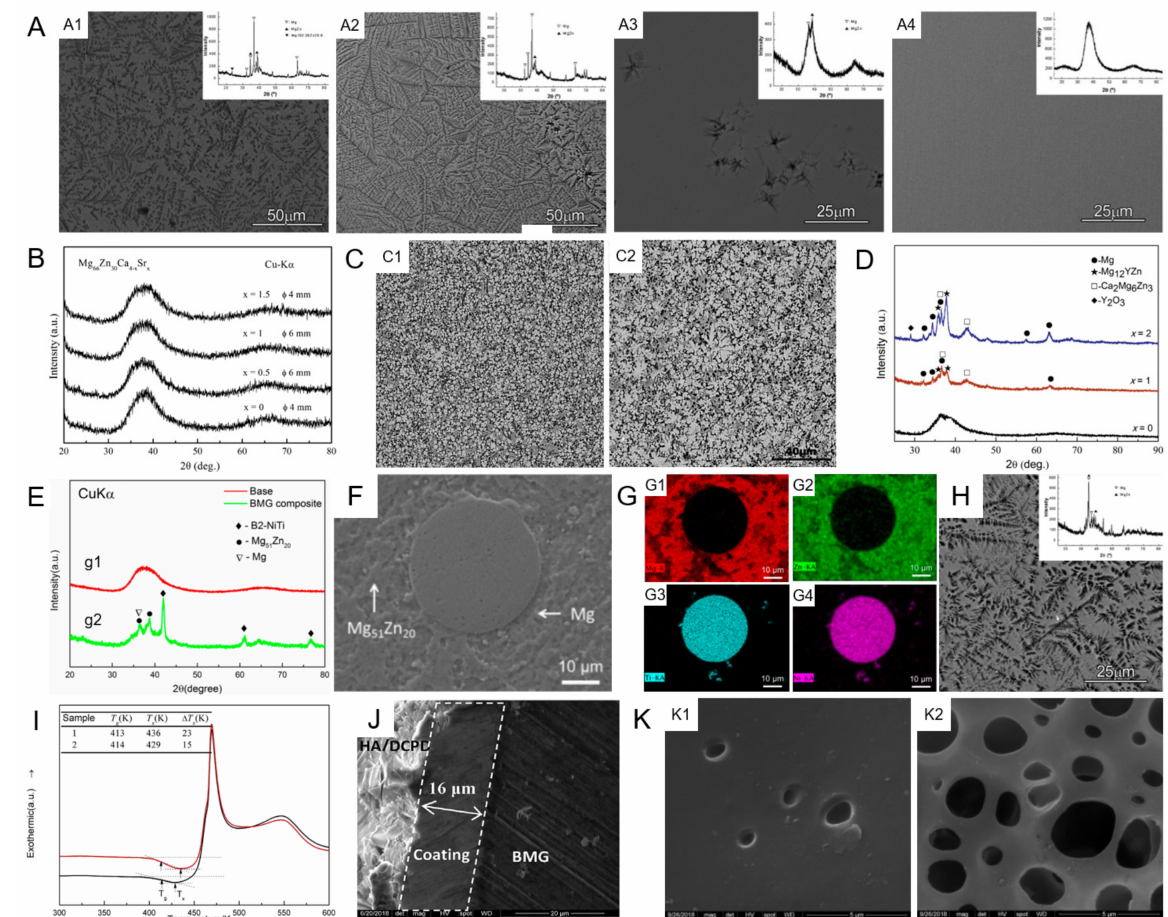
Figure 1. Microstructure of Mg–Zn–Ca-based MGs. ( A ) SEM images of as-cast alloys (diameter: 3 mm) with different Ca ratios: ( A1 ) Mg 71 Zn 28 Ca 1 , ( A2 ) Mg 70 Zn 28 Ca 2 , ( A3 ) Mg 69 Zn 28 Ca 3 ,